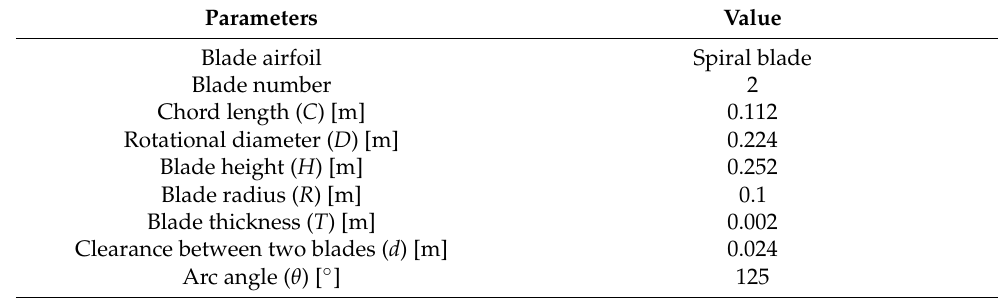
Figure 1. Schematic diagram of wind turbine model. ( a ) schematic diagram of basic type and spiral profile. ( b ) basic 3D graph. ( c ) spiral 3D graph. Table 1. Model parameters.